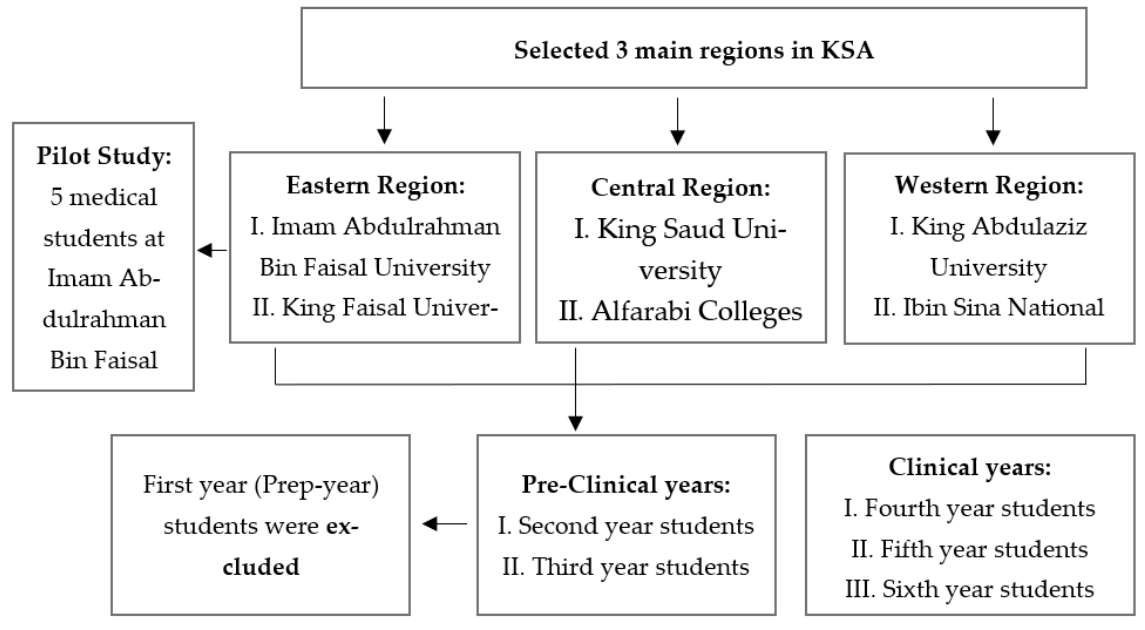
Figure 1. Data Collection